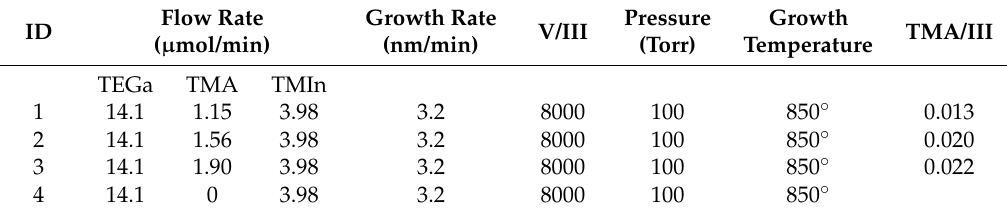
Table 1. Growth condition of samples. TEGa: triethylgallium; TMIn: trimethylindium.